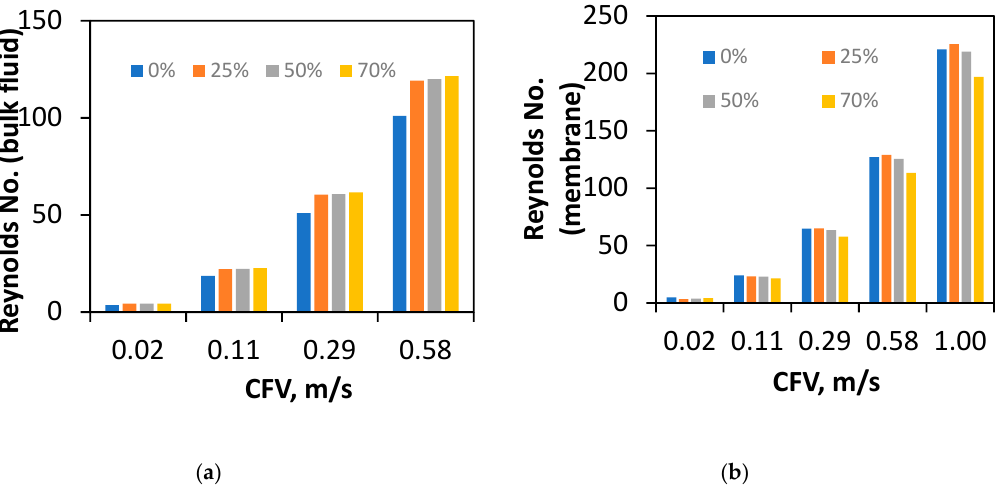
Figure 10. ( a ) Average Reynolds number of the interior PF channel and ( b ) average Reynolds on membrane surface.